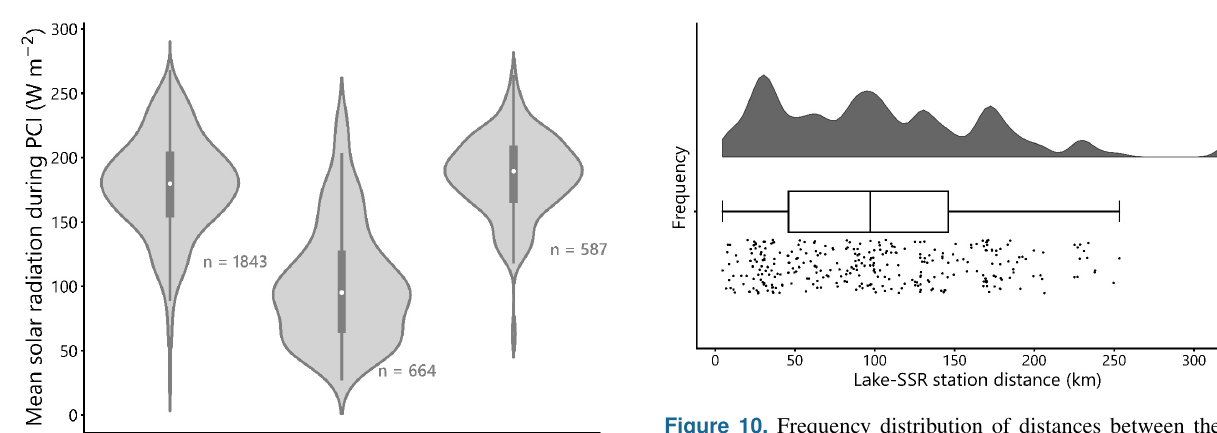
Figure 10. Frequency distribution of distances between the lake sampling points and the nearest surface solar radiation (SSR) sam- pling stations in decimal degrees. Most lake–SSR distances are within 200km of each other. Cloud cover, atmospheric aerosols, and their interactions are a major control on incident SSR at a given surface location; therefore, the SSR values may become less repre- sentative of the paired lake with increasing distances. The middle line in the boxplot shows the median